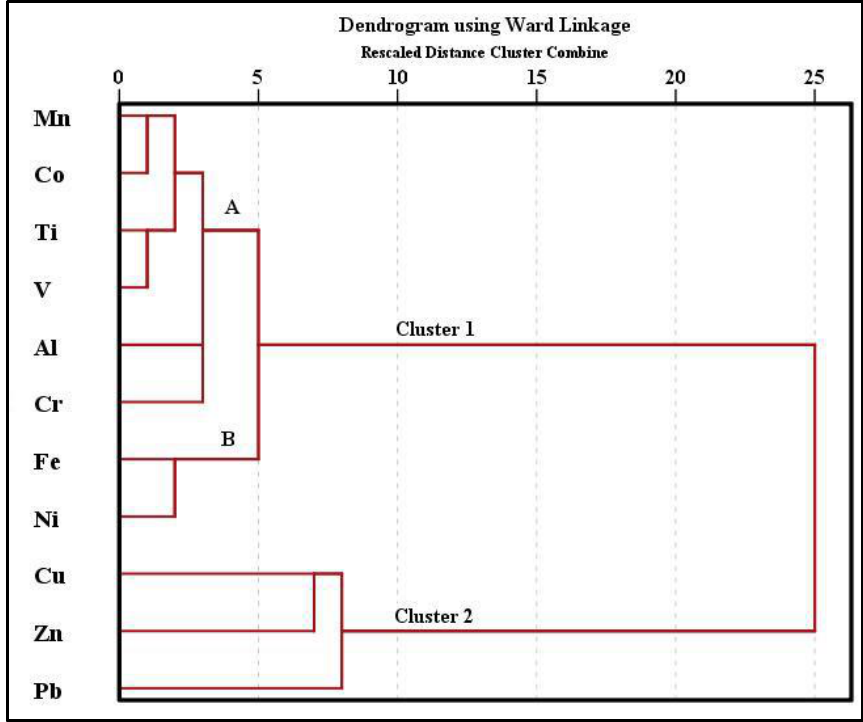
Figure 11. Dendrograms of PTEs and major elements using Ward’s method.